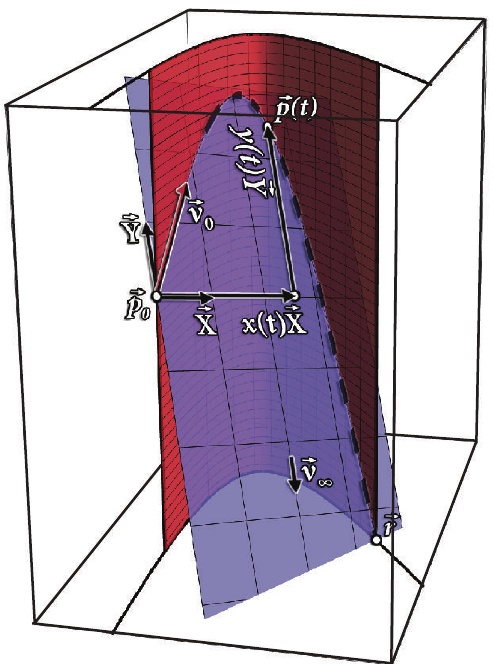
Figure 8: A 3D trajectory with wind at an angle, and its decompo- sition on the principal plane (in